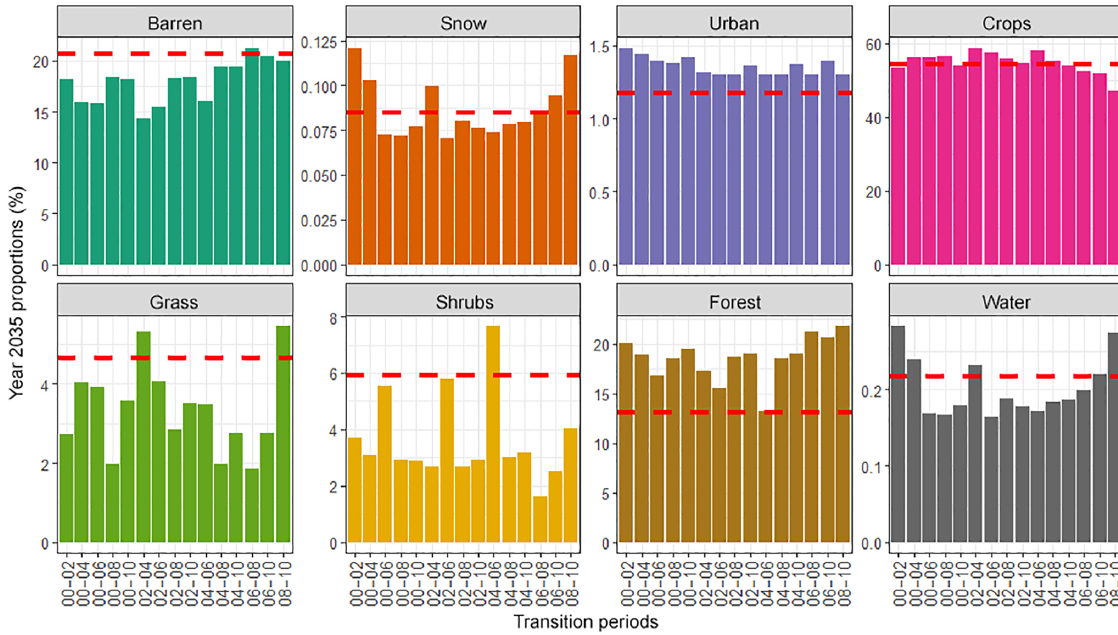
Figure 3. Plots indicating the different land uses for year 2035, amongst the 15 land-use pathways developed by applying the Markov chain simulation in Tsarouchi et al. (2014). The x axis indicates the transition period used to calibrate the Markov chain model; for instance, “00–02” refers to the historical period 2000–2002. The red line illustrates the actual land-cover proportions of year 2010, as derived from the Landsat